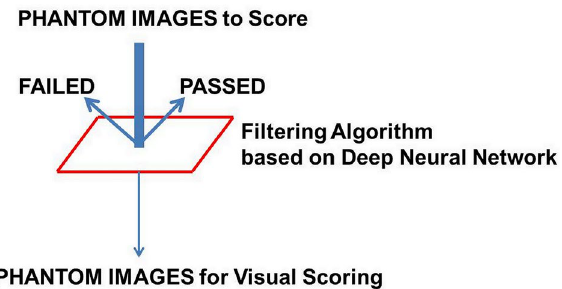
Figure 2. Study concept for reducing the phantom scoring workload. The thickness of the arrow indicates the volume of the image to